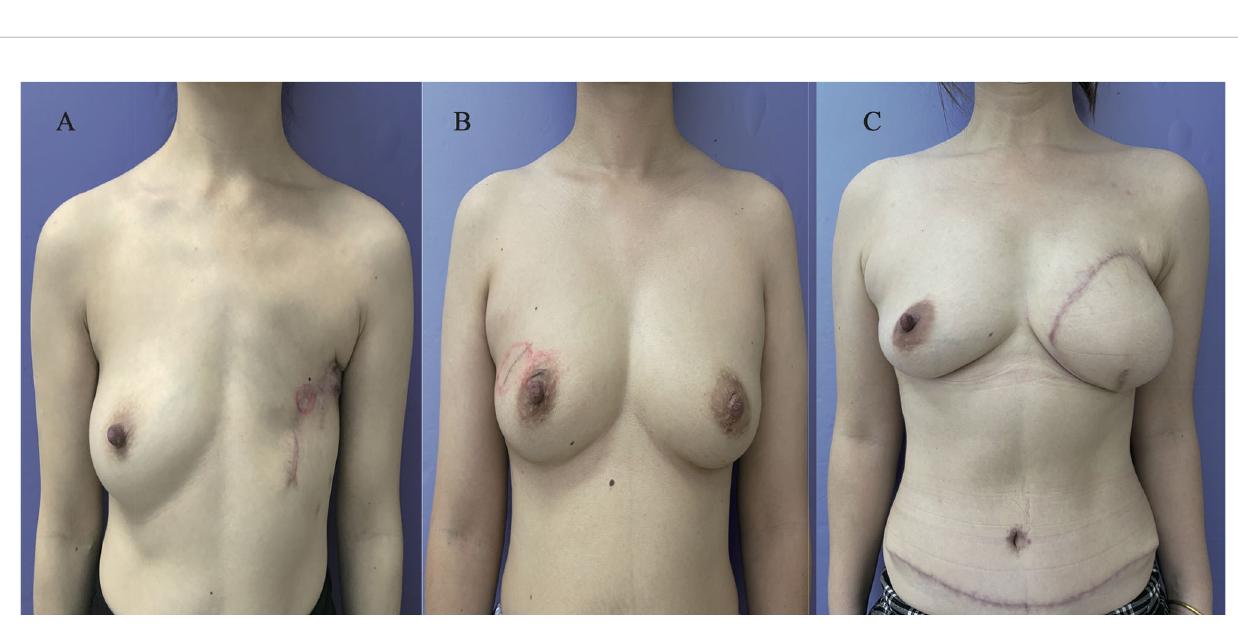
FIGURE 6 | Postoperative esthetic results of patients from surgical options. (A) The esthetic images of patients who underwent mastectomy alone after 1 year; (B) the esthetic images of patients who had breast-conservation surgery after 6 months; (C) the esthetic images of patients who underwent mastectomy with reconstruction [deep inferior epigastric perforator fl ap (DIEP)] after 3